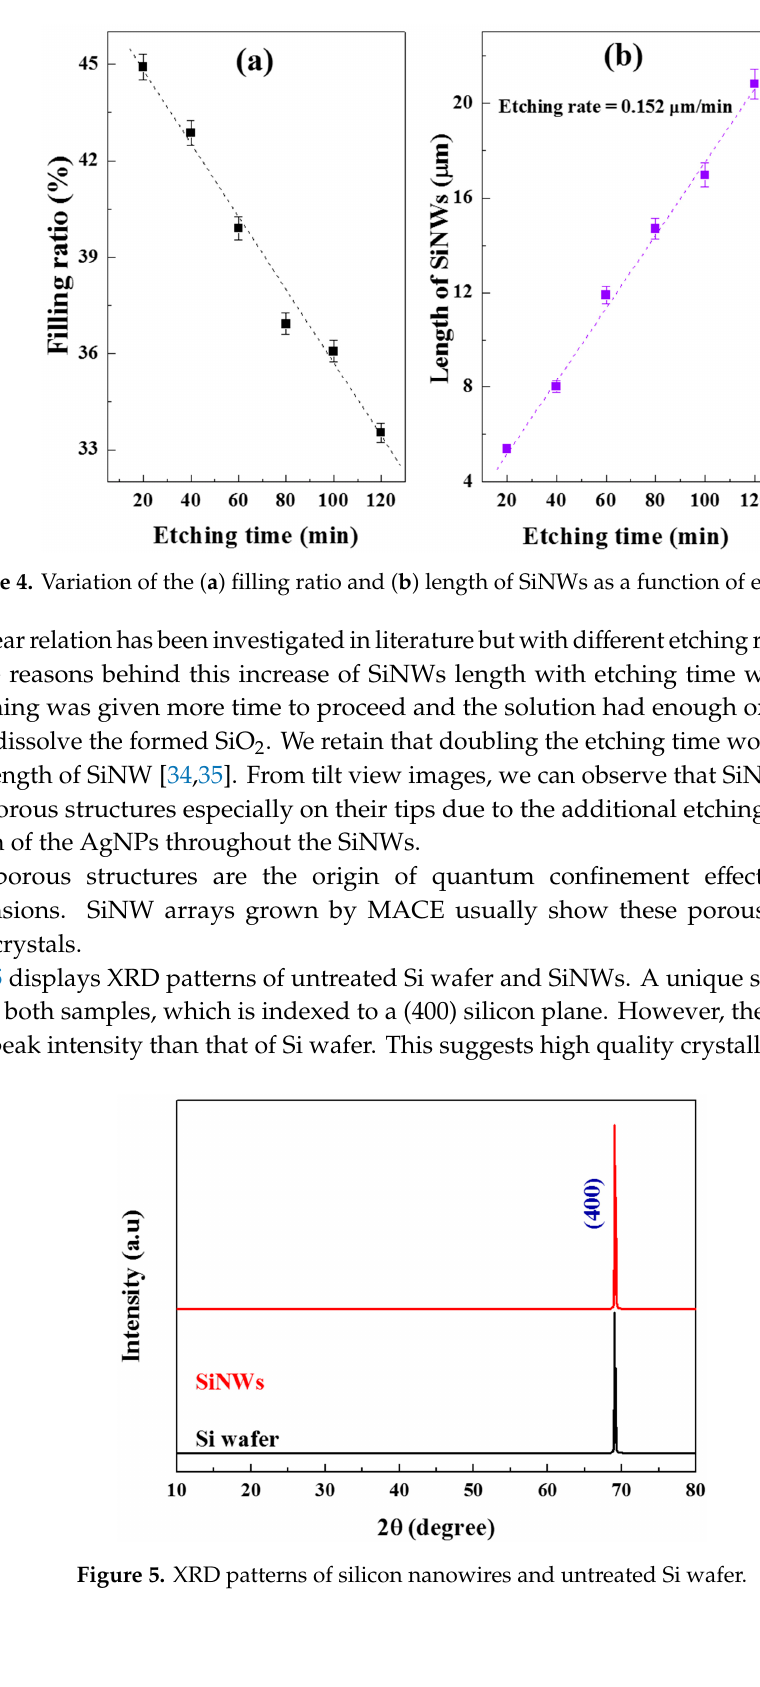
Figure 6. PL spectra of SiNWs synthesized at different etching times.